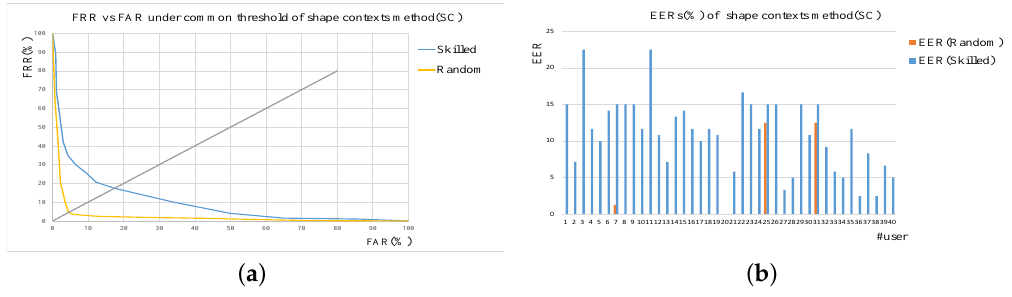
Figure 5. Results of shape context-based verification method (SC). ( a ) ROC curves under common threshold. ( b ) EER of each user under user